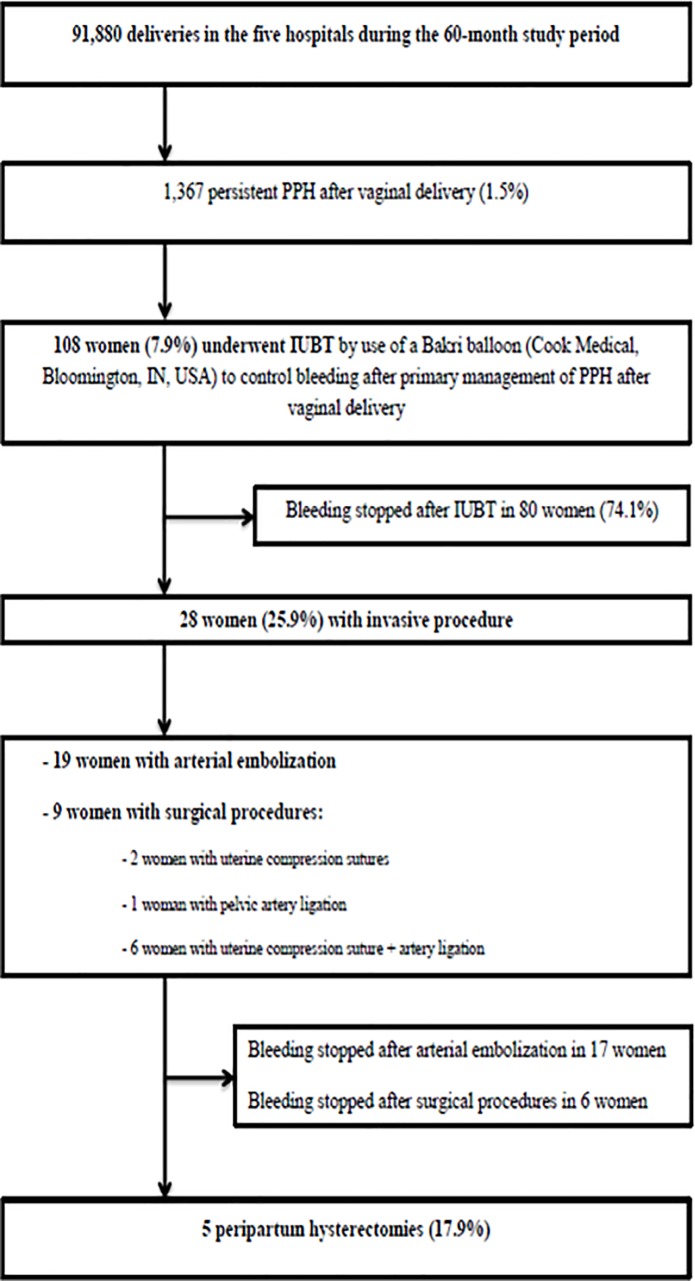
Cohort flowchart.